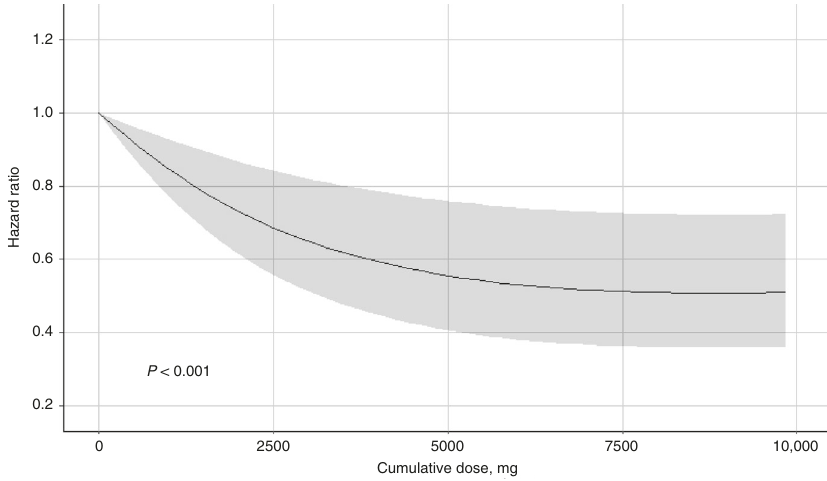
Fig. 3 Dose – response association of PDE5 inhibitors with CRC-speci fi c mortality. Colorectal cancer CRC, Hazard ratio HR, Con fi dence interval CI. Cox regression model by using restricted cubic splines with three knots was used to assess dose – response relationship. HR was adjusted for age at diagnosis, year of diagnosis, cancer stage at diagnosis, birth country, marital status, highest education, income, prescription of other medicines (including aspirin, steroid, and statin), depression, and Charlson Comorbidity Index. Shadow part indicates the 95% CI for the HR.